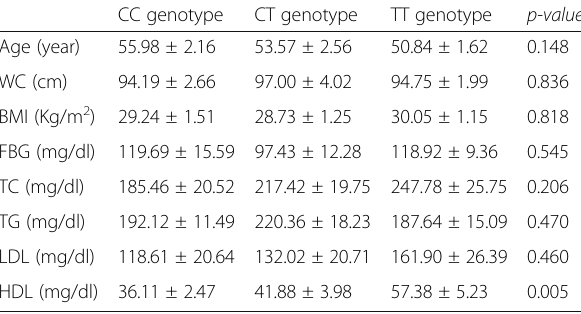
Table 3 Relationship of ABCC8 (C/T) polymorphism with demographic and clinical characteristics of participants